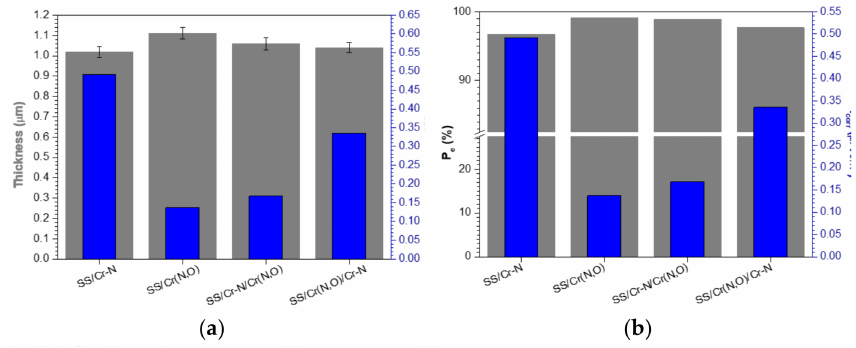
Figure 9. The variation of the corrosion current density ( i corr ) versus: ( a ) coatings’ thickness; ( b ) protection efficiency ( P e